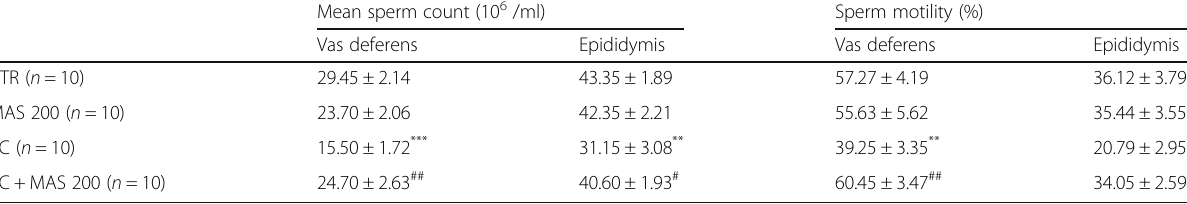
Table 2 Effect of MAS 200 on sperm count, sperm motility in vas deference and epididymis in varicocele-induced male SD